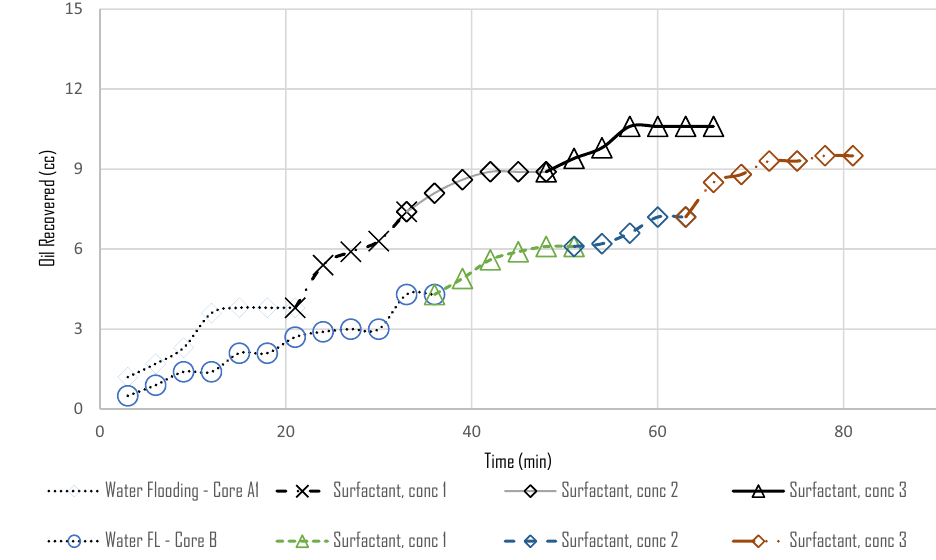
Fig. 9 Recovery potential of surfactant at different concen- trations at 0.2 wt% to 0.5 wt% against time. Experimental condition: temperature at 28 °C